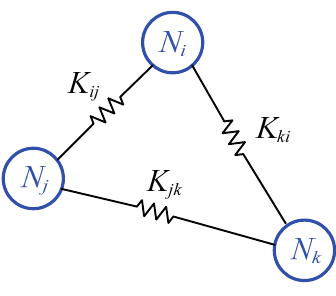
Figure 3. Interconnected nodes with springs.